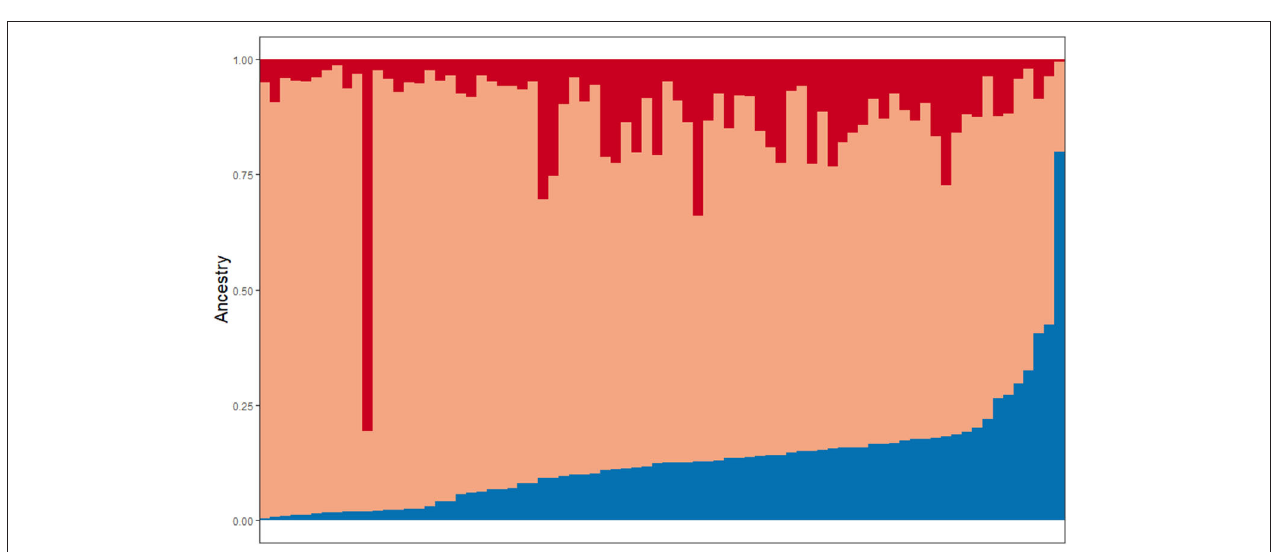
FIGURE 2 | Representation of ancestral admixture in Latino cohort. Subjects are sorted on the X-axis based on percentage of Amerindian ancestry contribution (0–80%, displayed in blue). Colors in each vertical line represent that individual’s ancestral admixture. Red = African, Orange = European, Blue = Amerindian.